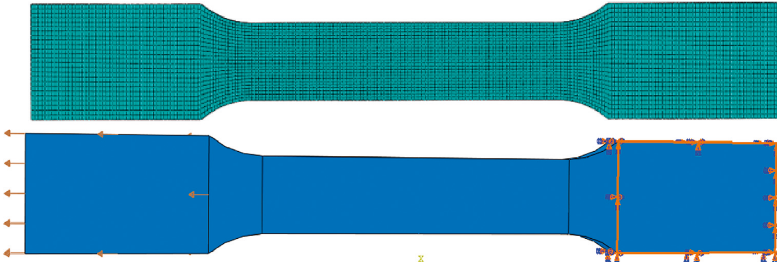
Figure 16: Grid partitioning and loading pattern